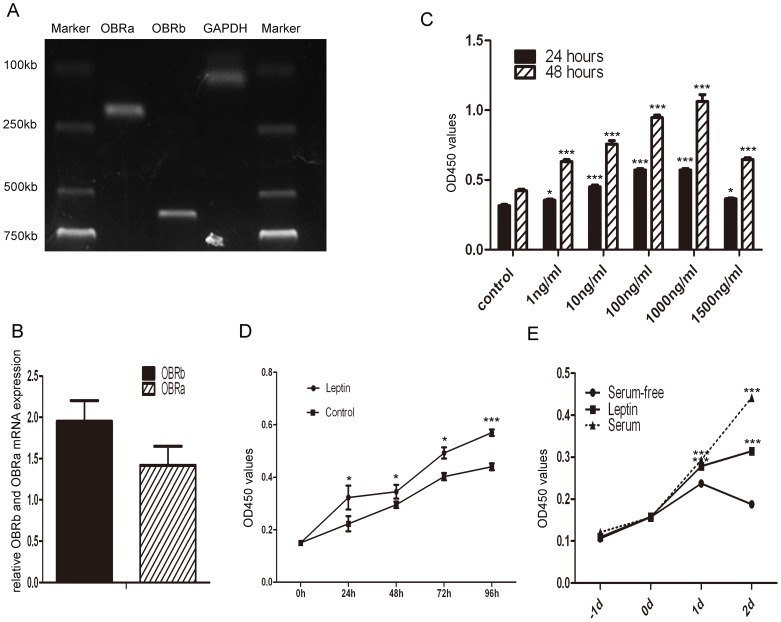
Leptin stimulates NP cells growth.(A) The mRNA expression of OBRa and OBRb were detected in human NP cell with RT-PCR. The amplified cDNA fragments, 116 bp GAPDH, 609 bp OBRb, and 200 bp OBRa, together with DNA marker were electrophoresed. (B) Real-time RT-PCR analysis of OBRa and OBRb mRNA in NP cells. Real-time RT-PCR analysis was performed in triplicate and the expression levels of OBRa and OBRb mRNAs were normalized to GAPDH mRNAs. Error bars represent standard deviration. (C) For the dose-development studies NP cells were treated with either complete culture medium only or varying concentrations of leptin (1–1500 ng/ml) for 48 or 72 h. (D) For the time-development studies, NP cells were treated either complete culture medium only or leptin (10 ng/ml) for varying time intervals (24–96 h). (E) To further compare the cell viabilities before and after leptin treatment, NP cells were serum starved before treatment (day -1), and 1 day later treated with 10 ng/ml leptin, serum in serum-free media or vehicle (control group) over 2 days. Values are presented as mean ±SD (n = 4). The statistically differences compared with the control are noted as *p<0.05, and ***p<0.001. Data represent three independent experiments.